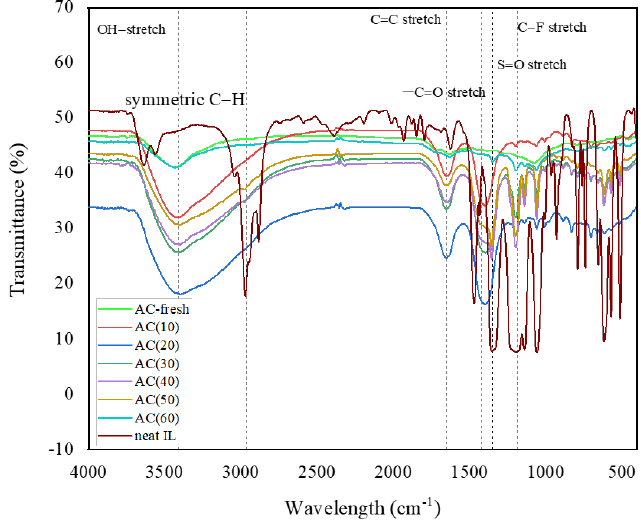
Figure 6. FTIR spectra of fresh and functionalized AC.